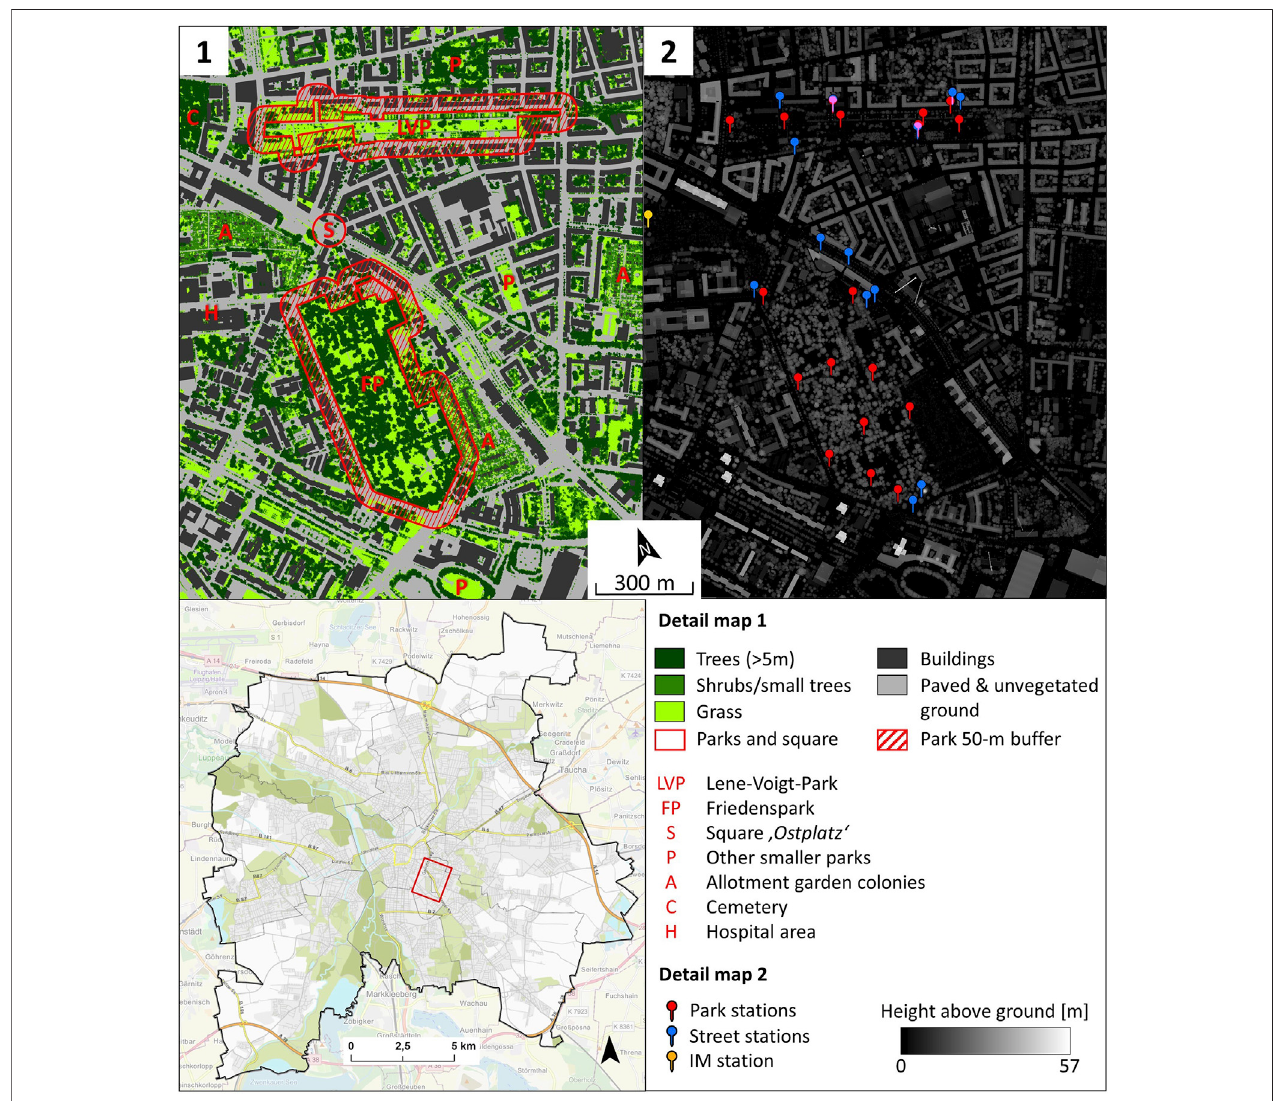
FIGURE 2 | Bottom left: Location of the study area (red rectangle) in the city of Leipzig. Detail map 1: Study area with land cover, delineated zones for cooling assessment, and further areas of interest. Detail map 2: Study area with location of meteorological data loggers (for further details of data loggers see